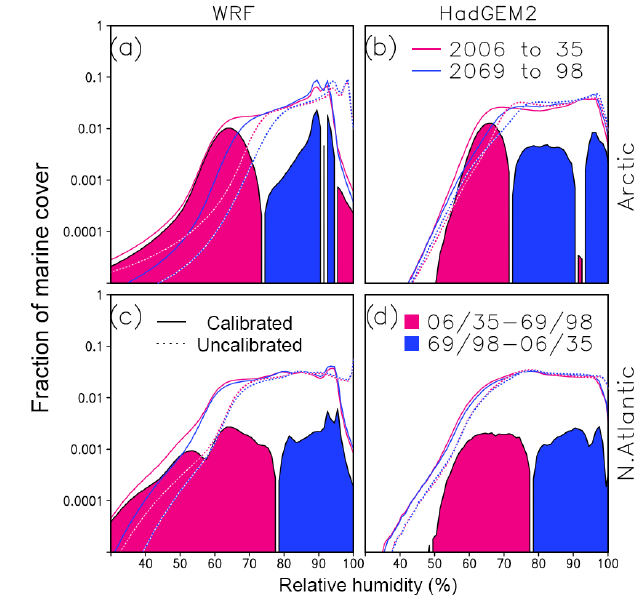
Figure 5. Predicted (RCP4.5) distribution shifts in relative humid- ity with and without a homogeneous two-step calibration. Shown are the fraction of marine coverage as a function of calibrated (solid lines) and uncalibrated (dashed lines) relative humidity with re- spect to water (at 1% intervals) for the years 2006–2035 (red lines) and 2069–2098 (blue lines). Fractions are shown on a logarithmic scale for the WRF (a, c) and HadGEM2 (b, d) simulations in the Arctic (a, b) and North Atlantic (c, d) . Calibrated positive differ- ences for 2006–2035 minus 2069–2098 (red) and 2069–2098 minus 2006–2035 (blue) are shaded. Note that HadGEM2 relative humid- ity is obtained from daily averages of air and dew point